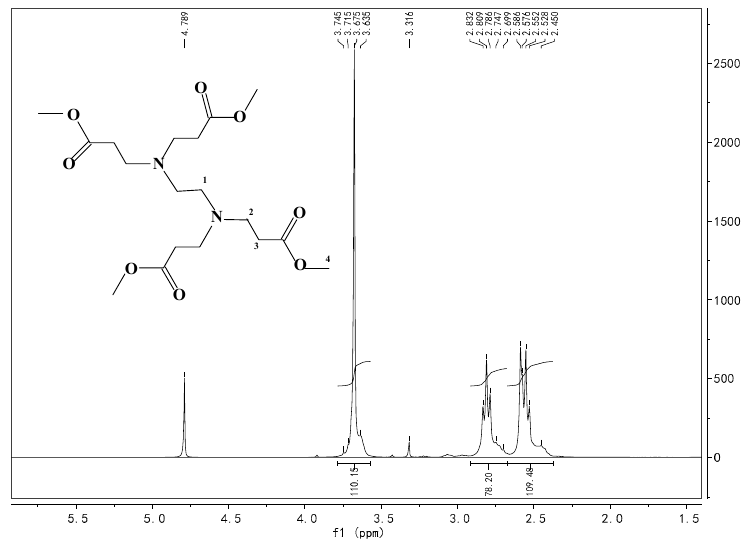
Figure A1. 1 H NMR spectrum of precursor of intermediate-1 of HBP.